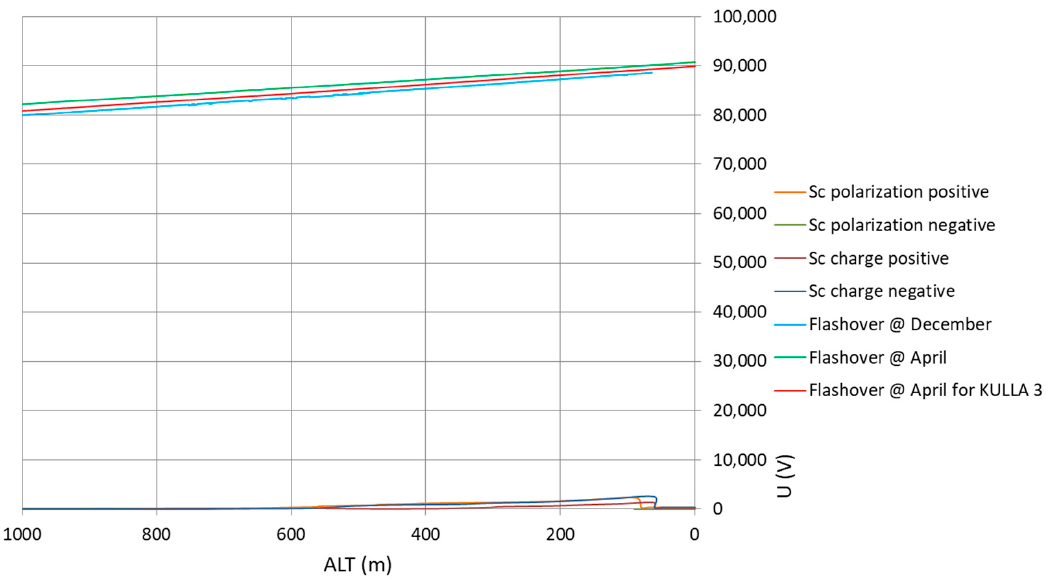
Figure 6. The flashover and induced voltage for the re-entry through the Stratocumulus clouds on the 140 m-long fully airborne antenna.